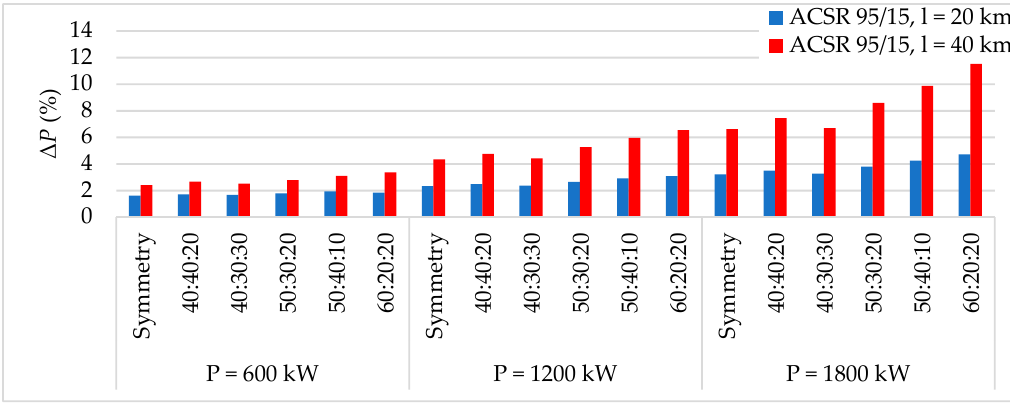
Figure 24. The comparison of the APLs for three types of active powers for conductor ACSR 42/7. Figure 25. The comparison of the APLs for three types of active powers for conductor ACSR 70/11.